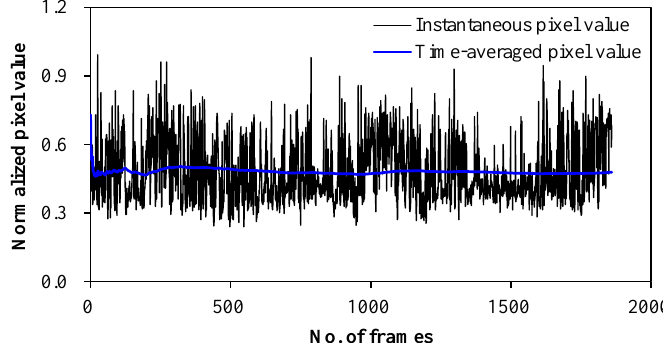
Figure 5. Time series of pixel values at a position of water surface.